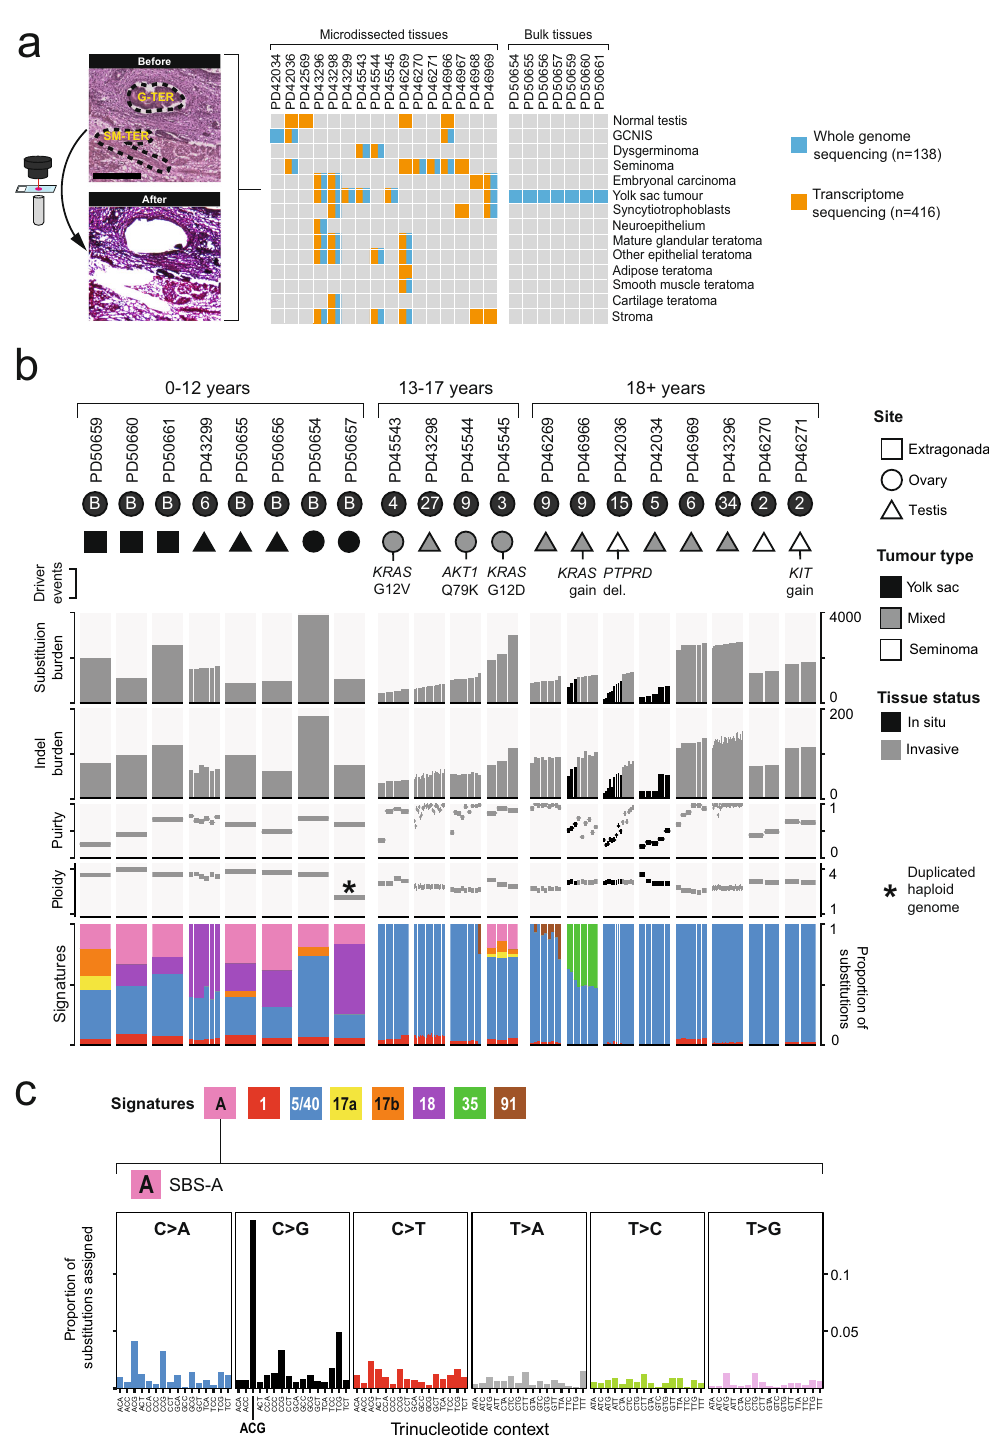
Fig. 1 The mutational pro fi le of GCTs. a Overview of the experimental design, including micrographs from PD46269 illustrating different tumour histologies amenable to microdissection and sequencing (Supplementary Data 1). Gamma changes have been applied to these micrographs to help distinguish the histological features. G-TER, glandular teratoma; SM-TER, smooth muscle teratoma. Scale bar represents 250 microns. The total number of whole genomes includes both the microdissected (131) and bulk (7) samples. Note that for the mixed tumours PD42034 and PD45545 only one histology was available for microdissection and PD42569 was normal testis from a healthy donor. b Summary plot of key genomic data and relevant metadata pertaining to each GCT analysed (Supplementary Data 1 – 2, 9). Samples are ordered by patient and age. Each patient is labelled as having either a single bulk whole genome (B) or with the number of individual histological units microdissected for WGS (dark grey circle beneath each patient ID). See Methods for driver annotation. c Trinucleotide context plot of SBS-A. Source data are provided as a Source Data fi le.